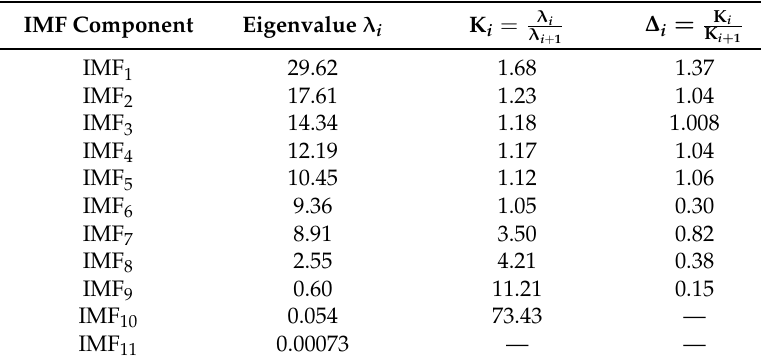
Table 1. IMF component, eigenvalue and ratio of joint signal.